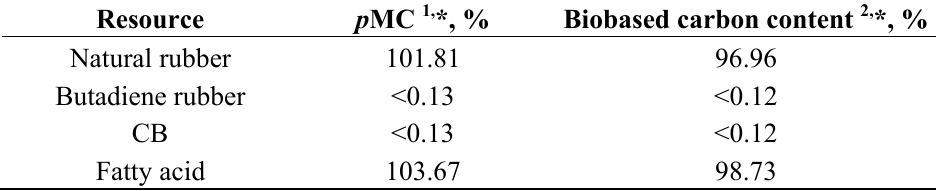
Table 8. Percent of modern carbon ( p MC) determined from 14 C concentration measured by AMS and biobased carbon content calculated from p MC for feed constituents.